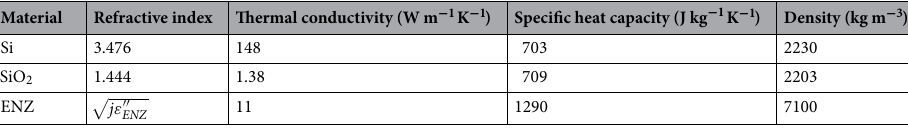
Table 1. Optical and thermal constants used for simulations.